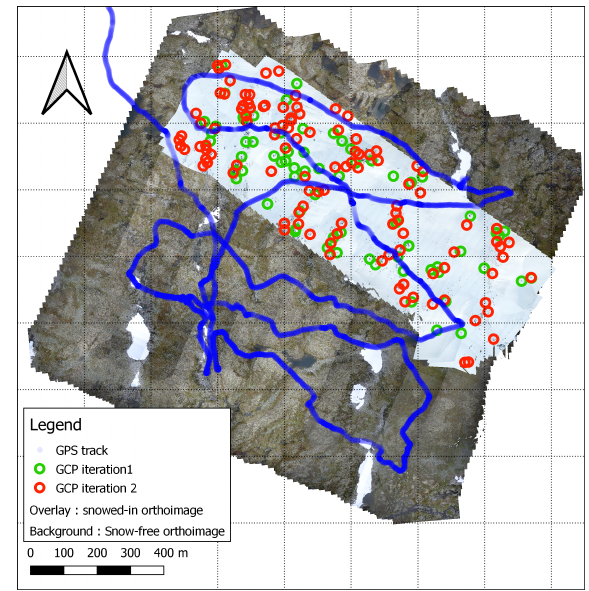
Figure 5. Location map of the Finse area and study area.